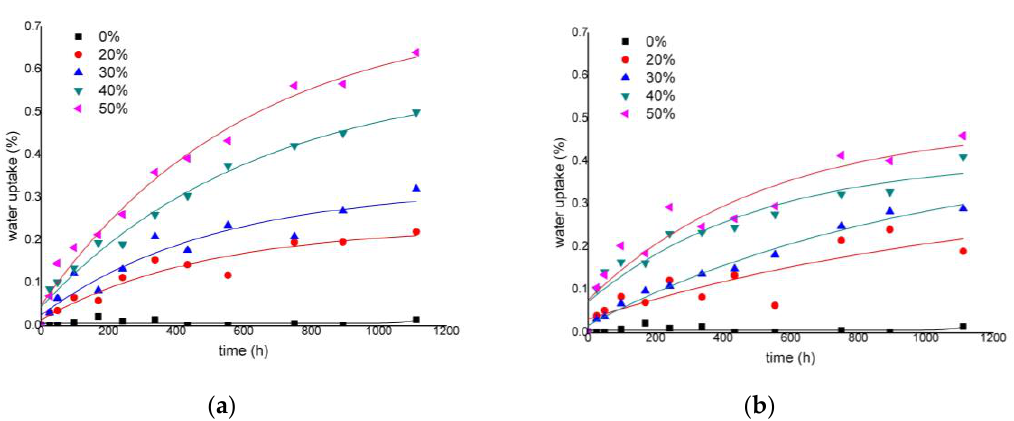
Figure 6. Water uptake profiles of composites reinforced with different percentages of ONPF at 23 °C and 50% RH: ( a ) Uncoupled ONPF composites; ( b ) Coupled ONPF composites.